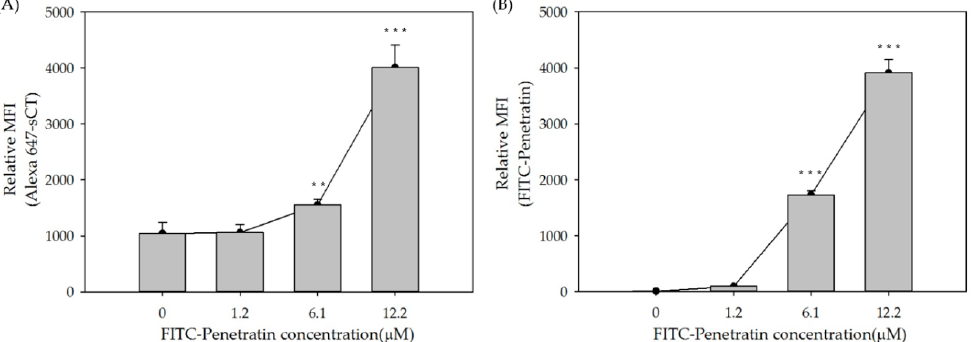
Figure 3. FACS data of FITC-Penetratin and Alexa 647-sCT internalization in TR146 cells. Relative MFI values of FITC-Penetratin ( A ) and relative MFI values of Alexa 647-sCT ( B ). All data were represented by mean ± S.D ( n = 3). ** p < 0.01 versus control and *** p < 0.001 versus control.